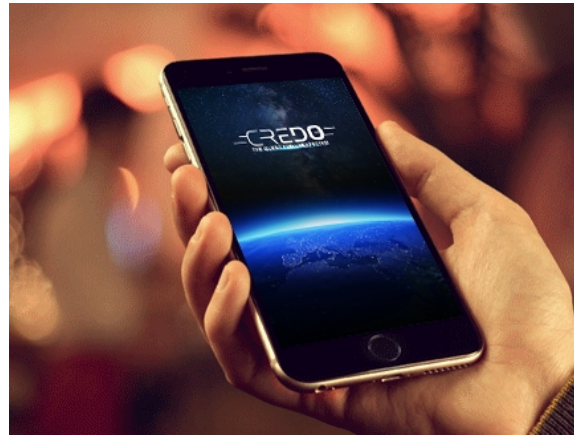
Figure 2. A smartphone with the CREDO application.